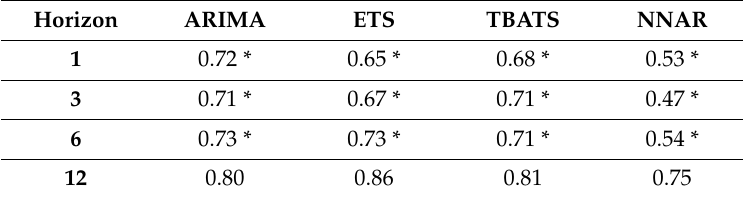
Figure 11. Singular spectrum analysis (SSA) signal extractions for “Burberry” fashion consumer Google Trends.